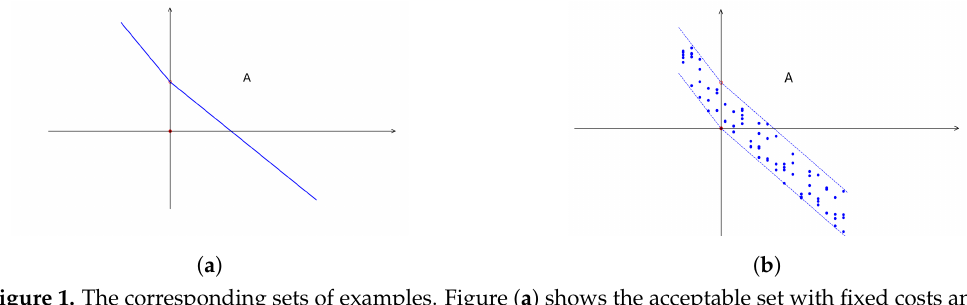
Figure 1. The corresponding sets of examples. Figure ( a ) shows the acceptable set with fixed costs and proportional transaction costs, Figure ( b ) shows the acceptable set with proportional transaction costs and stochastic